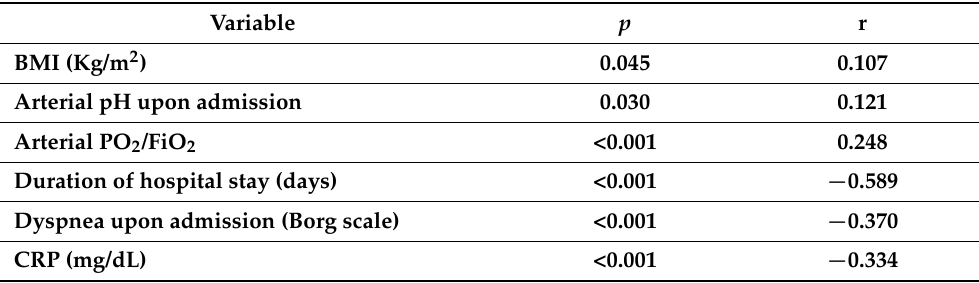
Table 2. Correlations between blood eosinophils and several patient